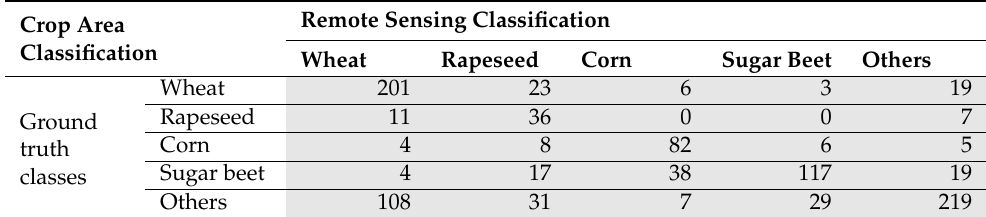
Table 3. Test points classification using Bivariate strategy, with 1000 pixels selected by simple random